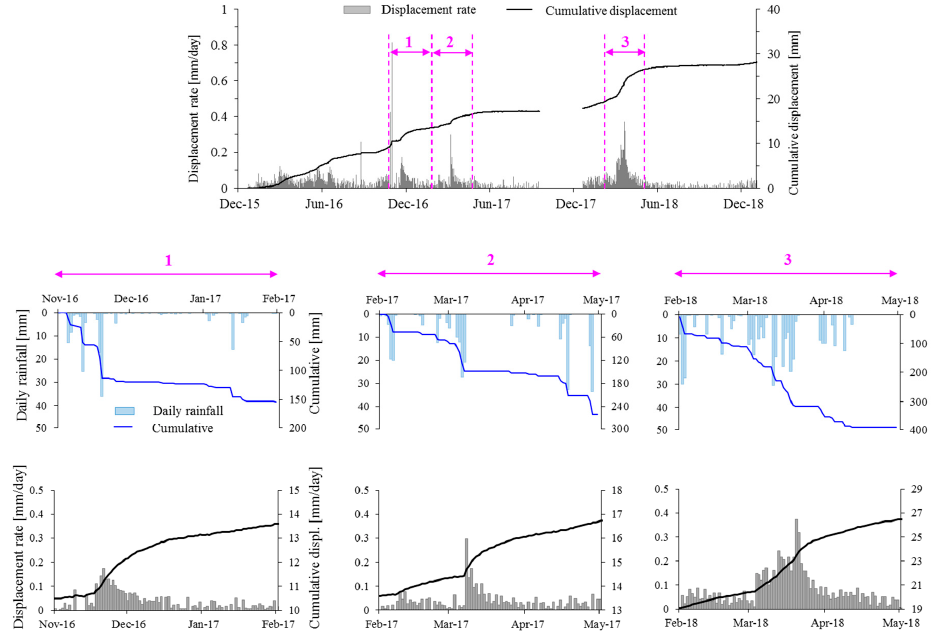
Figure 9. Focus on three reactivations of the landslide movement originated by rainfall: comparison between daily and cumulated rainfalls versus daily and cumulative displacements for AI11.